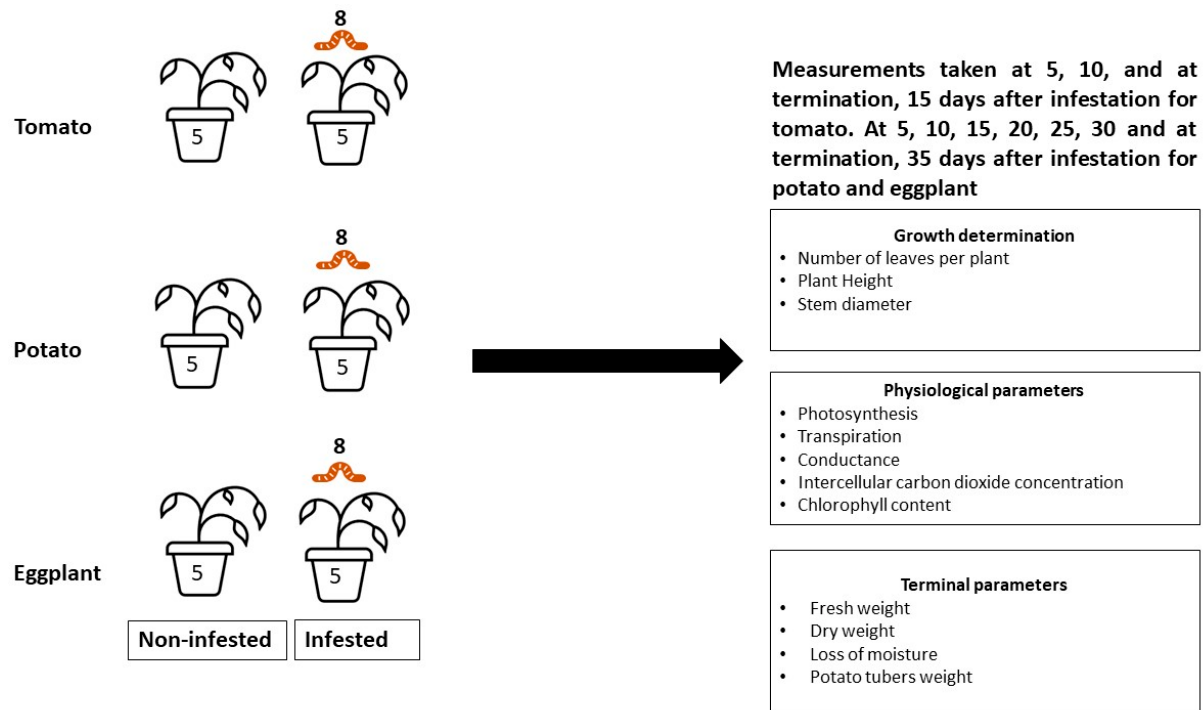
Figure 1. Experimental setup to determine the effects of Tuta absoluta infestations on the growth and physiological parameters of tomato, potato, and eggplant.